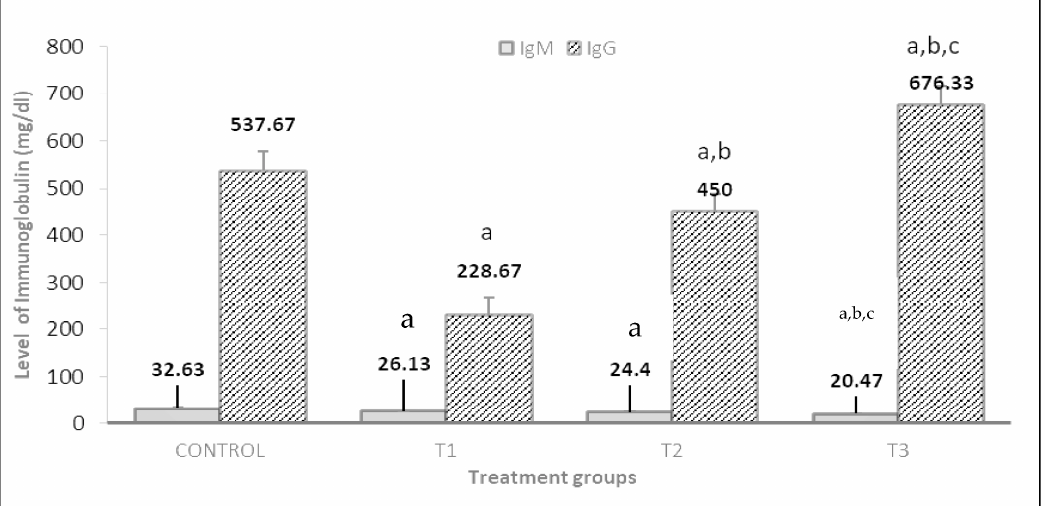
Figure 10. Effect of pomegranate peel and garlic powder separately or in combination on serum immunoglobulin IgG and IgM levels of does. Values are presented as means ± SE (n = 5 litters). T1; pomegranate peel 3%, T2; garlic 3% and T3; pomegranate peel 1.5% + garlic 1.5%. IgG is immunoglobulin G and IgM is immunoglobulin M. a Significant difference as compared to the control. b Significant differences as compared to T1 and c significant differences as compared to T2 ( p < 0.05).